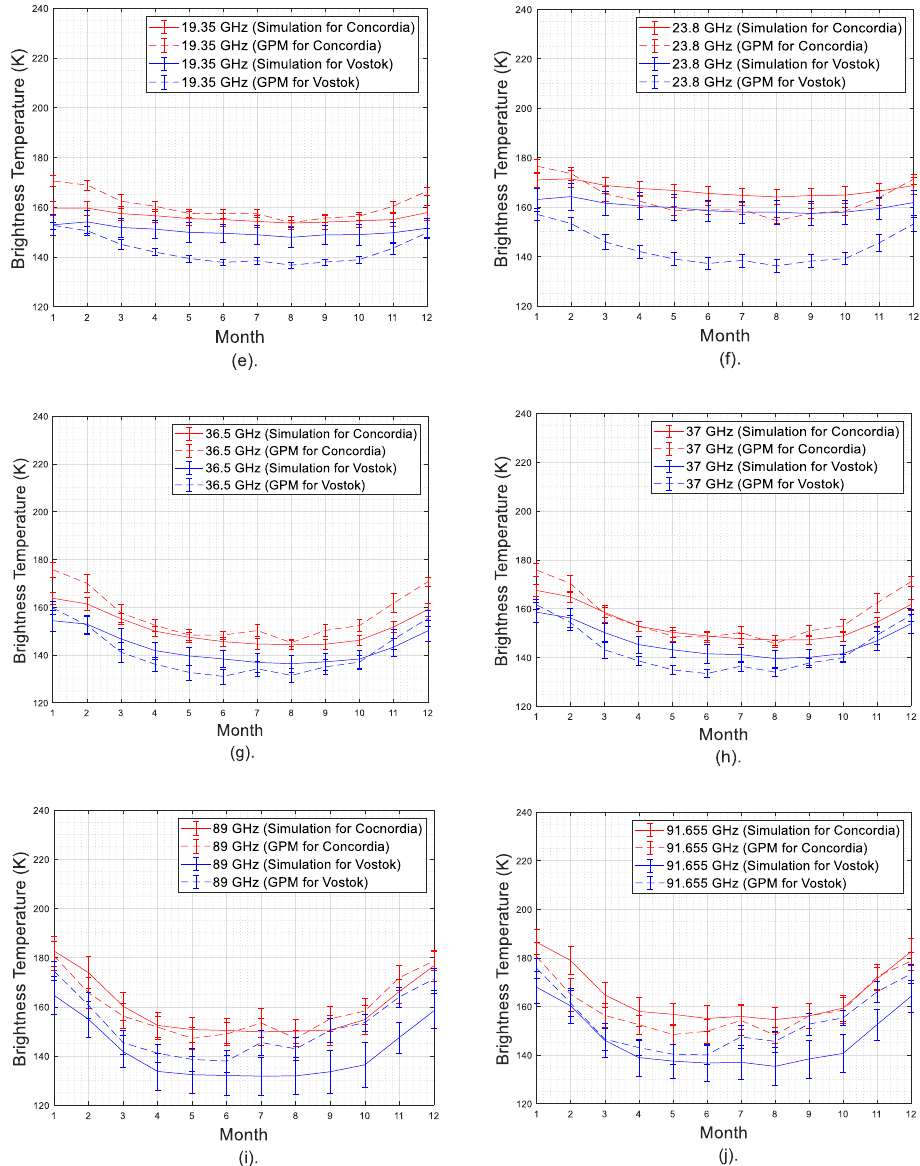
Figure 16. Comparative analysis of calculated and measured brightness temperatures at Concordia and Vostok Stations at frequencies ( a ) 6.9 GHz, ( b ) 7.3 GHz, ( c ) 10.65 GHz, ( d ) 18.7 GHz, ( e ) 19.35 GHz, ( f ) 23.8 GHz, ( g ) 36.5 GHz, ( h ) 37 GHz, ( i ) 89 GHz, and ( j ) 91.65 GHz. Physical temperature of the firn is another major factor determining the surface brightness temperature and can be probed at different depths using microwave radiometry. This can be demonstrated by investigating the correlations between the brightness temperatures measured by the GPM radiometers and the physical temperatures of the Antarctic firn at average depths of sensitivity associated with the GPM frequencies. Figure 17 illustrates these correlations at Concordia Station. The correlations have been demonstrated by co-plotting the deviations of the measured brightness and physical